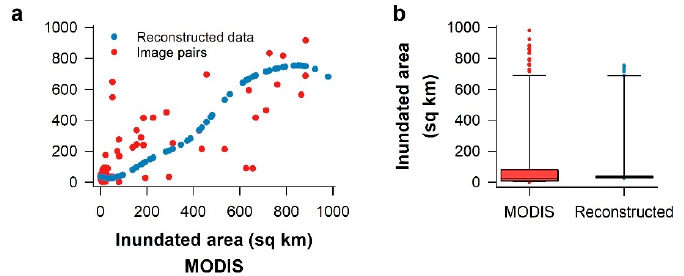
Figure 10. Reconstructed data from Support Vector Machine Regression (SVR) analysis ( a ) . Comparison of image pairs used for Support Vector Machine (SVM) regression analysis and reconstructed data. The 105 image pairs used to train the SVM regression model are plotted in red and the SVR results are plotted in blue. The x -axis indicates original inundated area in sq km derived from Terra MODIS and y -axis indicates inundated area data in sq km from Landsat/Sentinel-2 (for the red dots) and from reconstructed data (for the blue dots); ( b ) . Box plots showing the inundated area in square kilometers from Terra MODIS sensor (left) and the reconstructed value (right). The y -axis shows inundated area (MODIS data and reconstructed values) in sq km.